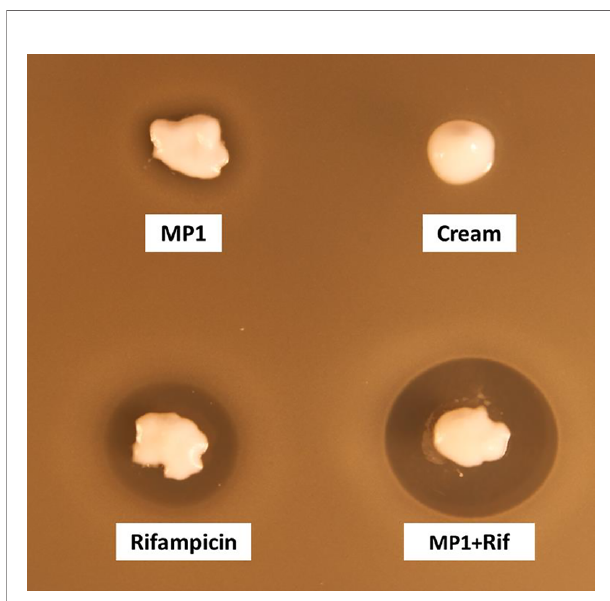
FIGURE 3 | Assessment of the antimicrobial activity of MP1(10 µg/ml), rifampicin (150 µg/ml) and the combination (MP1, 10µg/ml + rifampicin, 150µg/ml) in APO base cream 30%. Cream with not addition was included as negative control. The activity was tested with softagar overlay assay using MRSA Xen31 as indicator